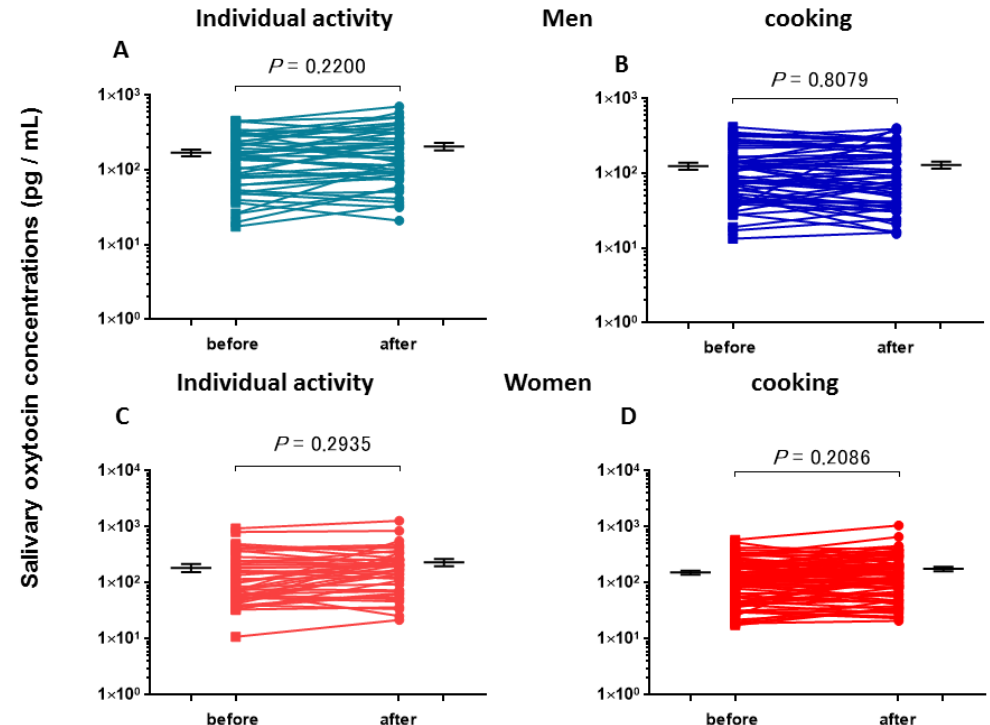
Figure 1. Oxytocin (OT) concentrations before and after a single group (cooking) or non-group (individual activity) session. OT levels are for the first (before) and second (after) salivary samples collected from nine men and nine women engaged in cooking in a group or in individual desk or bench work for approximately 1 h. p -values are for two-tailed Student’s t -tests: ( A ) individual activity by men, p = 0.2200, n = 46; ( B ) cooking by men, p = 0.8079, n = 55; ( C ) individual activity by women, p = 0.2935, n = 44; ( D ) cooking by women, p = 0.2086, n = 90.